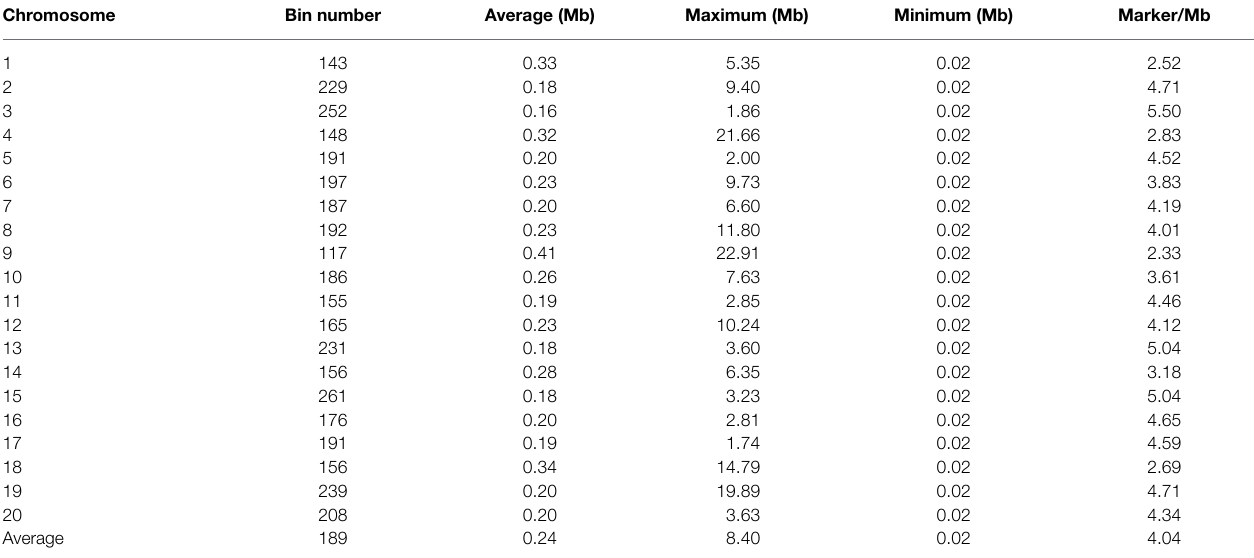
TABLE 3 | The bin marker number and marker density across 20 chromosomes of the CSSLs. Chromosome Bin number Average